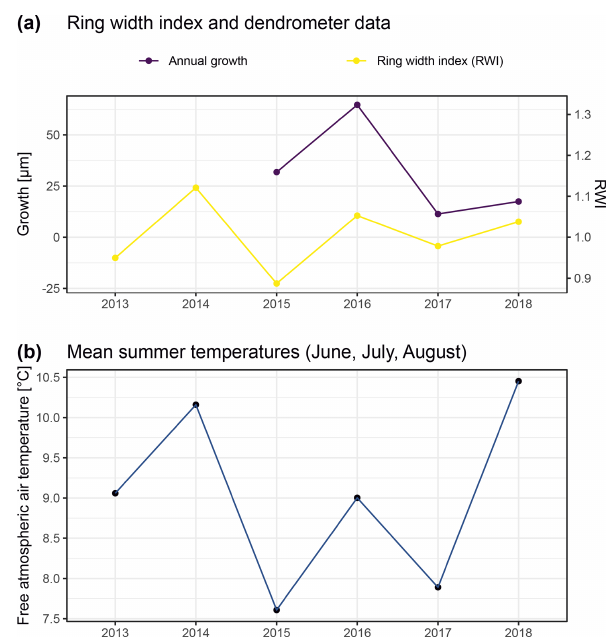
Figure A9. Comparison of annual growth measured using den- drometers (see “Material and methods”) and ring width derived by measuring annual growth rings of 12 specimens from similar po- sitions on exposed ridges, presented here as the ring width index (RWI). Ring width was measured from multiple micro-slices per specimen (following Bär et al., 2006; a ). Panel (b) shows free at- mospheric air temperatures measured at 2m above ground in both study regions. Such temperature data are commonly used for com- parison of climate–growth relationships in dendroecological stud- ies. With this figure we aimed to reproduce previous studies (Bär et al., 2006, 2007) for comparison with our dendrometer measure-